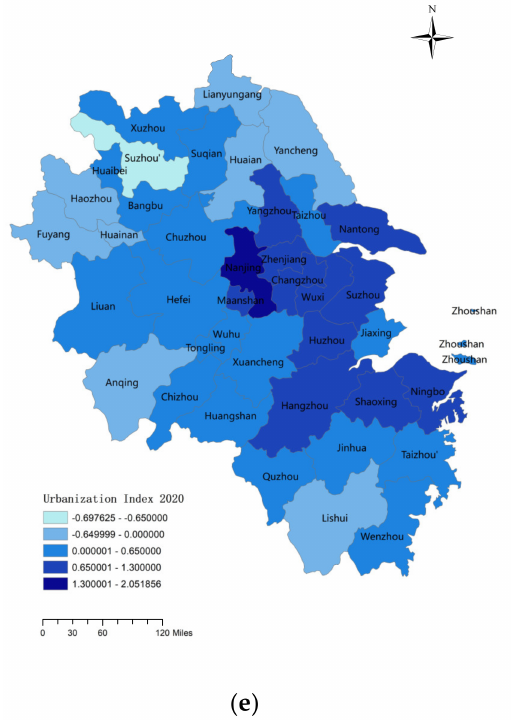
Figure 3. Spatial distribution map of urbanization level, 2016–2020. Panels ( a – e ) show the results for each year from 2016 to 2020,